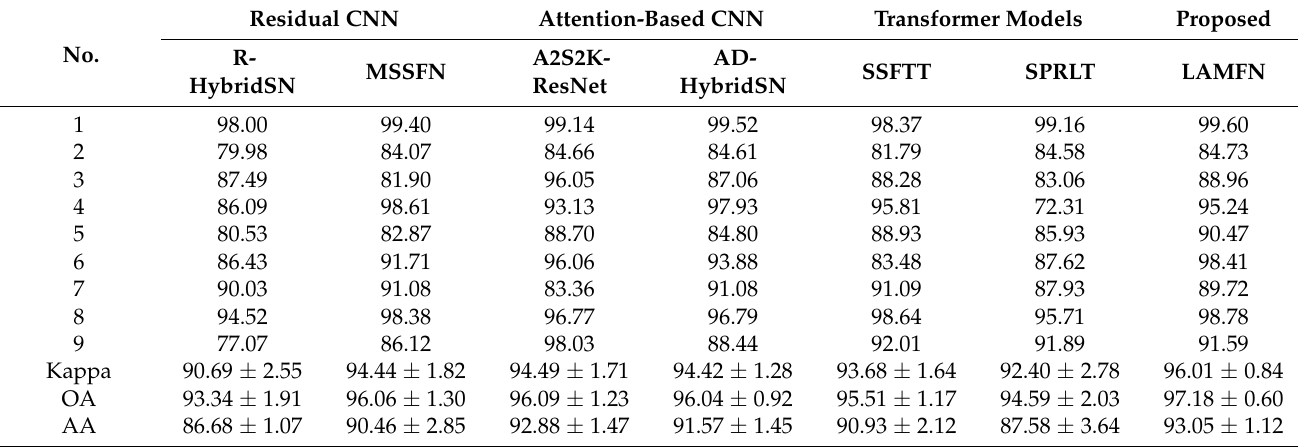
Table 4. Classification results of different models in PC